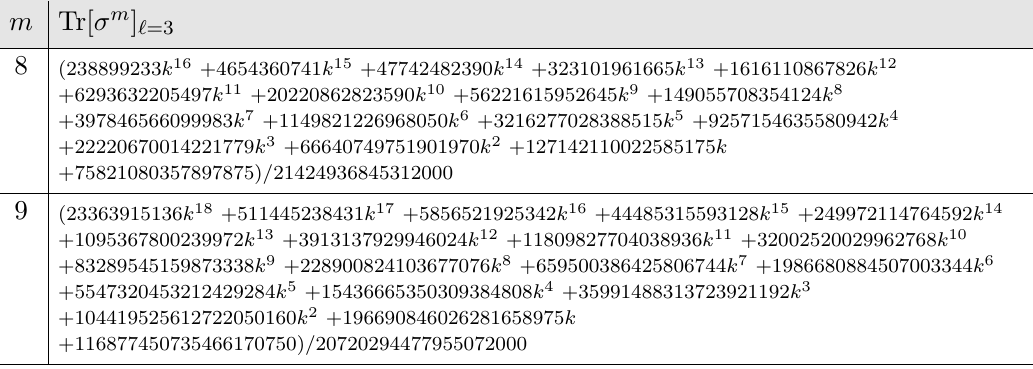
Table 9. The values of Tr [ σ m ] as a function of k for T 2 , 8 torus link. The subscript ‘ indicates that the polynomial is valid for k ≡ ‘ ( mod 4)